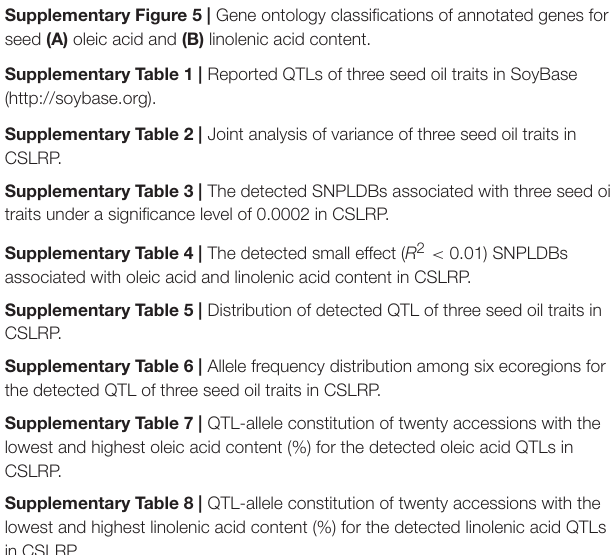
level of 0.05, and the red horizontal line represents Bonferroni-adjusted significance level of 0.05. Supplementary Figure 2 | The information of oleic acid QTL-allele matrix. (A) Effect distribution of 283 alleles on the 98 loci for the oleic acid content (%). (B) Distribution of number of alleles on the 98 loci for oleic acid content (%). (C) The graphical presentation of oleic acid QTL-allele matrix. The horizontal axis represents accessions arranged in a rising order of oleic acid content (%), while the vertical axis represents QTL arranged in a rising order of their positive allele frequency. Each row represents the allele distribution among accessions for a QTL, while each column indicates the allele constitution of an accession over all QTLs. Allele effects are expressed in color cells with warm colors indicating positive effects and cool colors indicating negative effects, and the color depth indicates effect size. Supplementary Figure 3 | The information of linolenic acid QTL-allele matrix. (A) Effect distribution of 154 alleles on the 50 loci for the linolenic acid content (%). (B) Distribution of the number of alleles on the 50 loci for linolenic acid content (%). (C) The graphical presentation of linolenic acid QTL-allele matrix. The horizontal axis represents accessions arranged in a rising order of linolenic acid content (%), while the vertical axis represents QTL arranged in a rising order of their positive allele frequency. Each row represents the allele distribution among accessions for a QTL, while each column indicates the allele constitution of an accession over all QTLs. Allele effects are expressed in color cells with warm colors indicating positive effects and cool colors indicating negative effects, and the color depth indicates effect size. Supplementary Figure 4 | The number of alleles shared among different number of ecoregions. Supplementary Figure 5 | Gene ontology classifications of annotated genes for seed (A) oleic acid and (B) linolenic acid content. Supplementary Table 1 | Reported QTLs of three seed oil traits in SoyBase (http://soybase.org). Supplementary Table 2 | Joint analysis of variance of three seed oil traits in CSLRP.